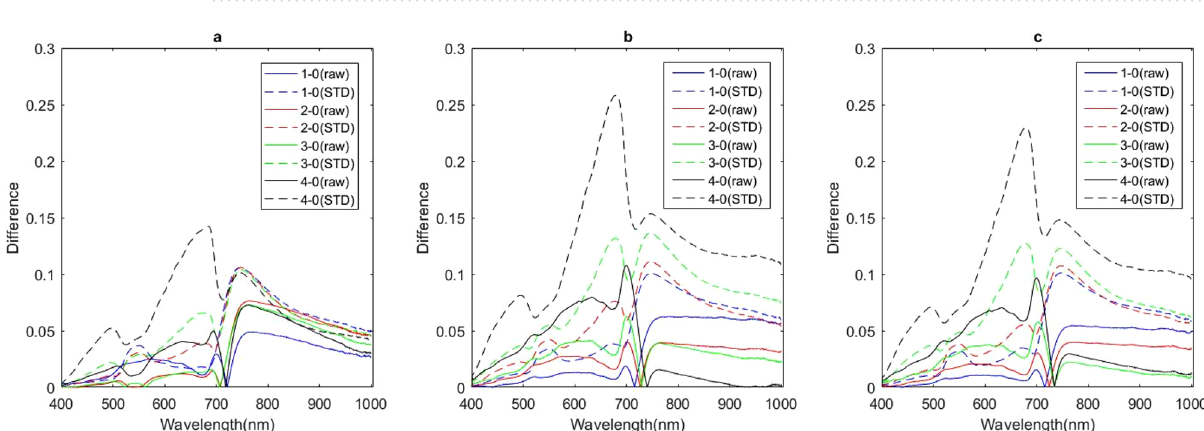
Figure 2. Average spectral reflectance and STD of leaves with different disease degree. ( a ) Average spectral reflectance at jointing stage; ( b ) average spectral reflectance at booting stage; ( c ) average spectral reflectance at heading stage; ( d ) average STD at jointing stage; ( e ) average STD at booting stage; ( f ) average STD at heading stage.